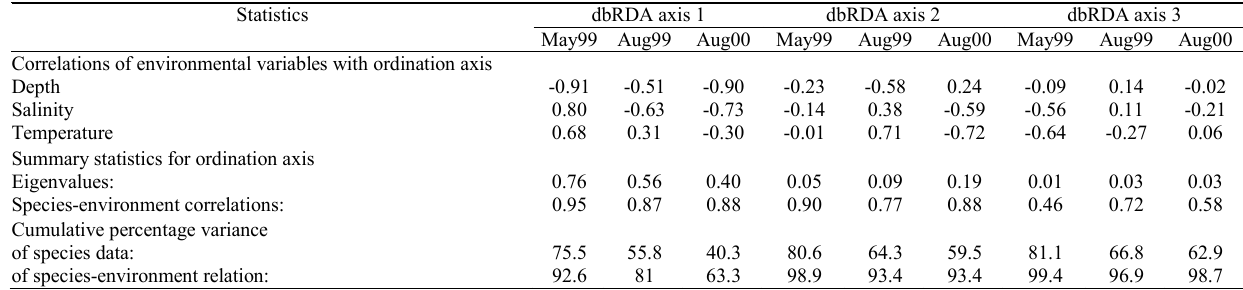
Table 5. Results of distance-based Redundancy Analysis (dbRDA) quantifying the statistical association between fish spatial patterns and environmental variables in the Lake